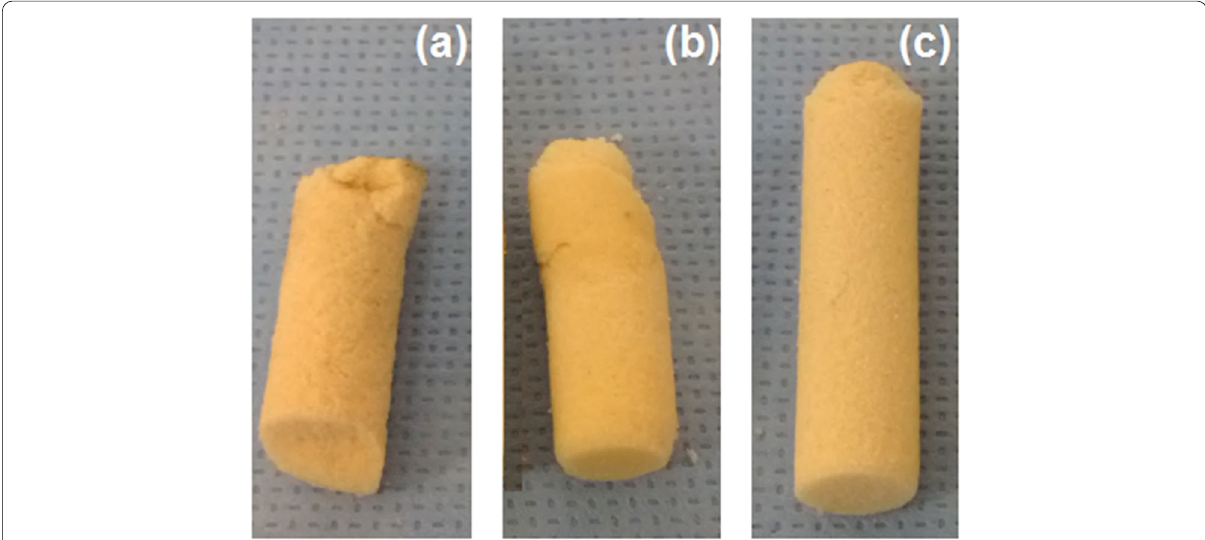
Fig. 11 Typical samples of core bone after the experiments: (a) Low density (group 1) core bones experienced maximum damage and become shorter with many small fragments, (b): Middle density (group 2) core bones turned into relatively longer plugs with a lower number, (c): High density (group 3) core bones experienced minimum